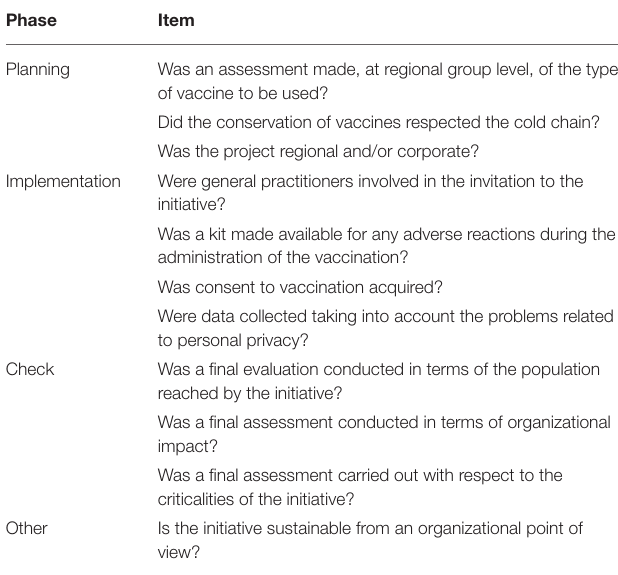
TABLE 2 | New items proposed for the inclusion in the tool after the first round of Delphi.